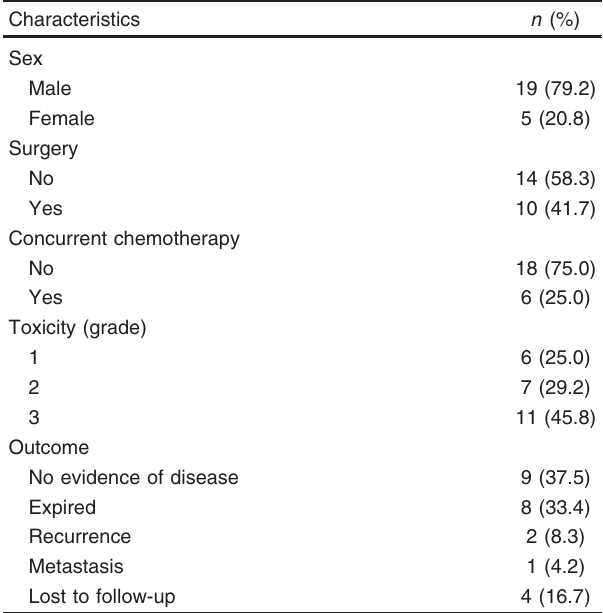
Table 1 General characteristics of the study population (n = 24)